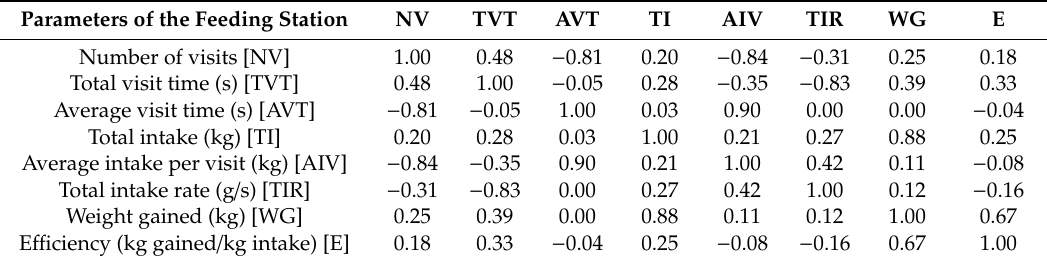
Table 4. Correlation between parameters obtained of the feeding